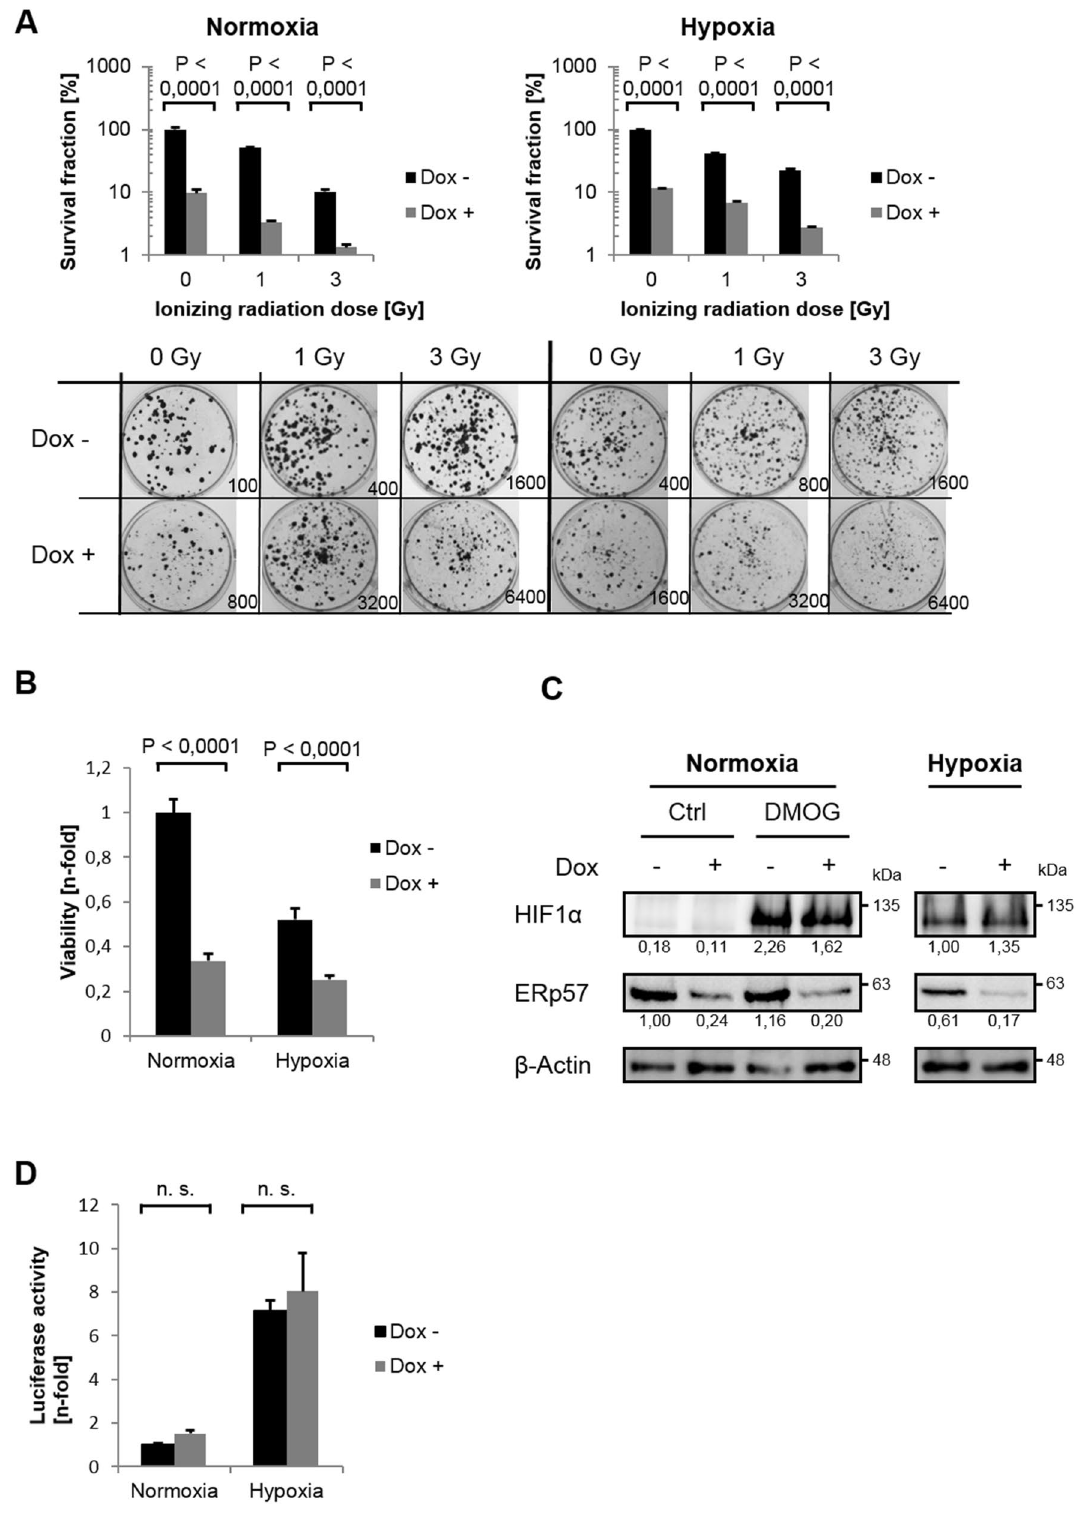
Figure 2. ERp57 promotes hypoxic proliferation, is radioprotective and does not effect HIF signaling. ( A ) For colony formation assay, cells were seeded supplemented with doxycycline and incubated under normoxic or hypoxic conditions. After 24 h, cells were irradiated with 0, 1 and 3 Gy and further incubated for 10 d before formed colonies were counted. Survival fraction was presented in bar graphs and representative images of colonies formed in 6 well plates are shown. The seeded cell number is indicated for each well. ( B ) MTT assay 96 h after ERp57 KD (n = 10). ( C ) Protein analysis of HIF1α 72 h after ERp57 KD and 24 h of hypoxia by western blot. As a positive control for HIF1α expression, normoxic cells were treated with 2 mM of prolyl-4-hydroxylase inhibitor dimethyloxalylglycine (DMOG). ( D ) HIF reporter gene assay. After co-transfection with pGLHIF1.3 (firefly luciferase, 3 × HRE) and pGL4.74 (renilla luciferase), ERp57 KD was induced. After 24 h in normoxia, cells were incubated for 48 h in normoxia/ hypoxia before cell lysis (n =